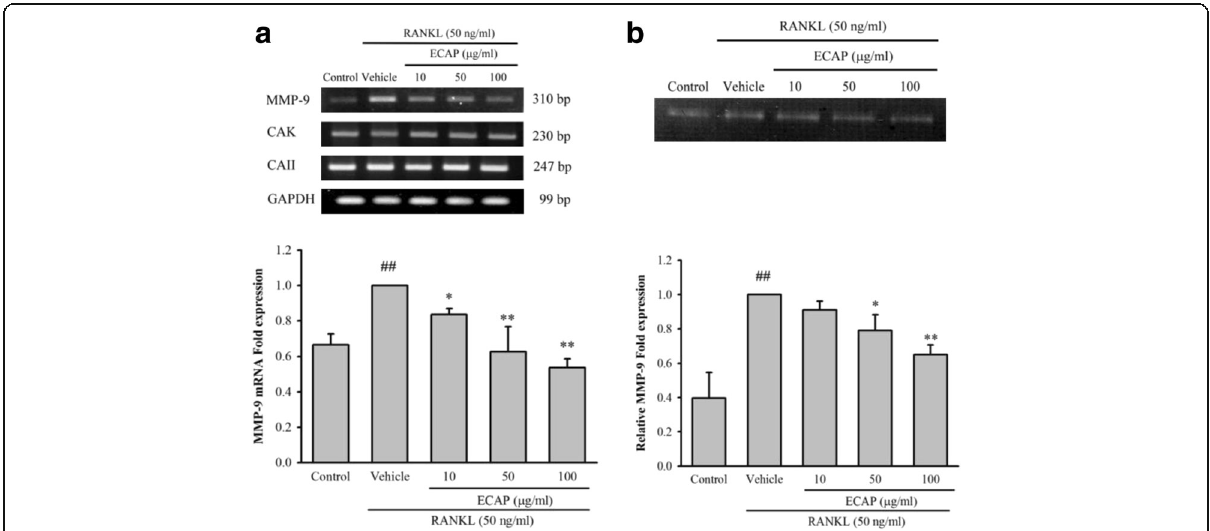
Fig. 3 Effects of ECAP on mRNA and protein expression of steoclastogenesis-related genes. a RAW 264.7 cells were cultured in the presence of RANKL (50 ng/ml) with the vehicle (H 2 O) or ECAP. After 24 h, total RNA was then isolated using TRIzol reagent, and mRNA expression levels were evaluated by RT-PCR. Glyceraldehyde- 3-phosphate dehydrogenase (GAPDH) was used as the internal control. b RAW 264.7 cells were cultured in the presence of RANKL (50 ng/ml) with the vehicle (H 2 O) or ECAP. After 24 h, the culture medium was collected and analyzed by gelatin zymography. Each value represents the mean ± SD. ( n = 3). ## P < 0.01 compared with control; * P < 0.05, ** P < 0.01 compared with RANKL